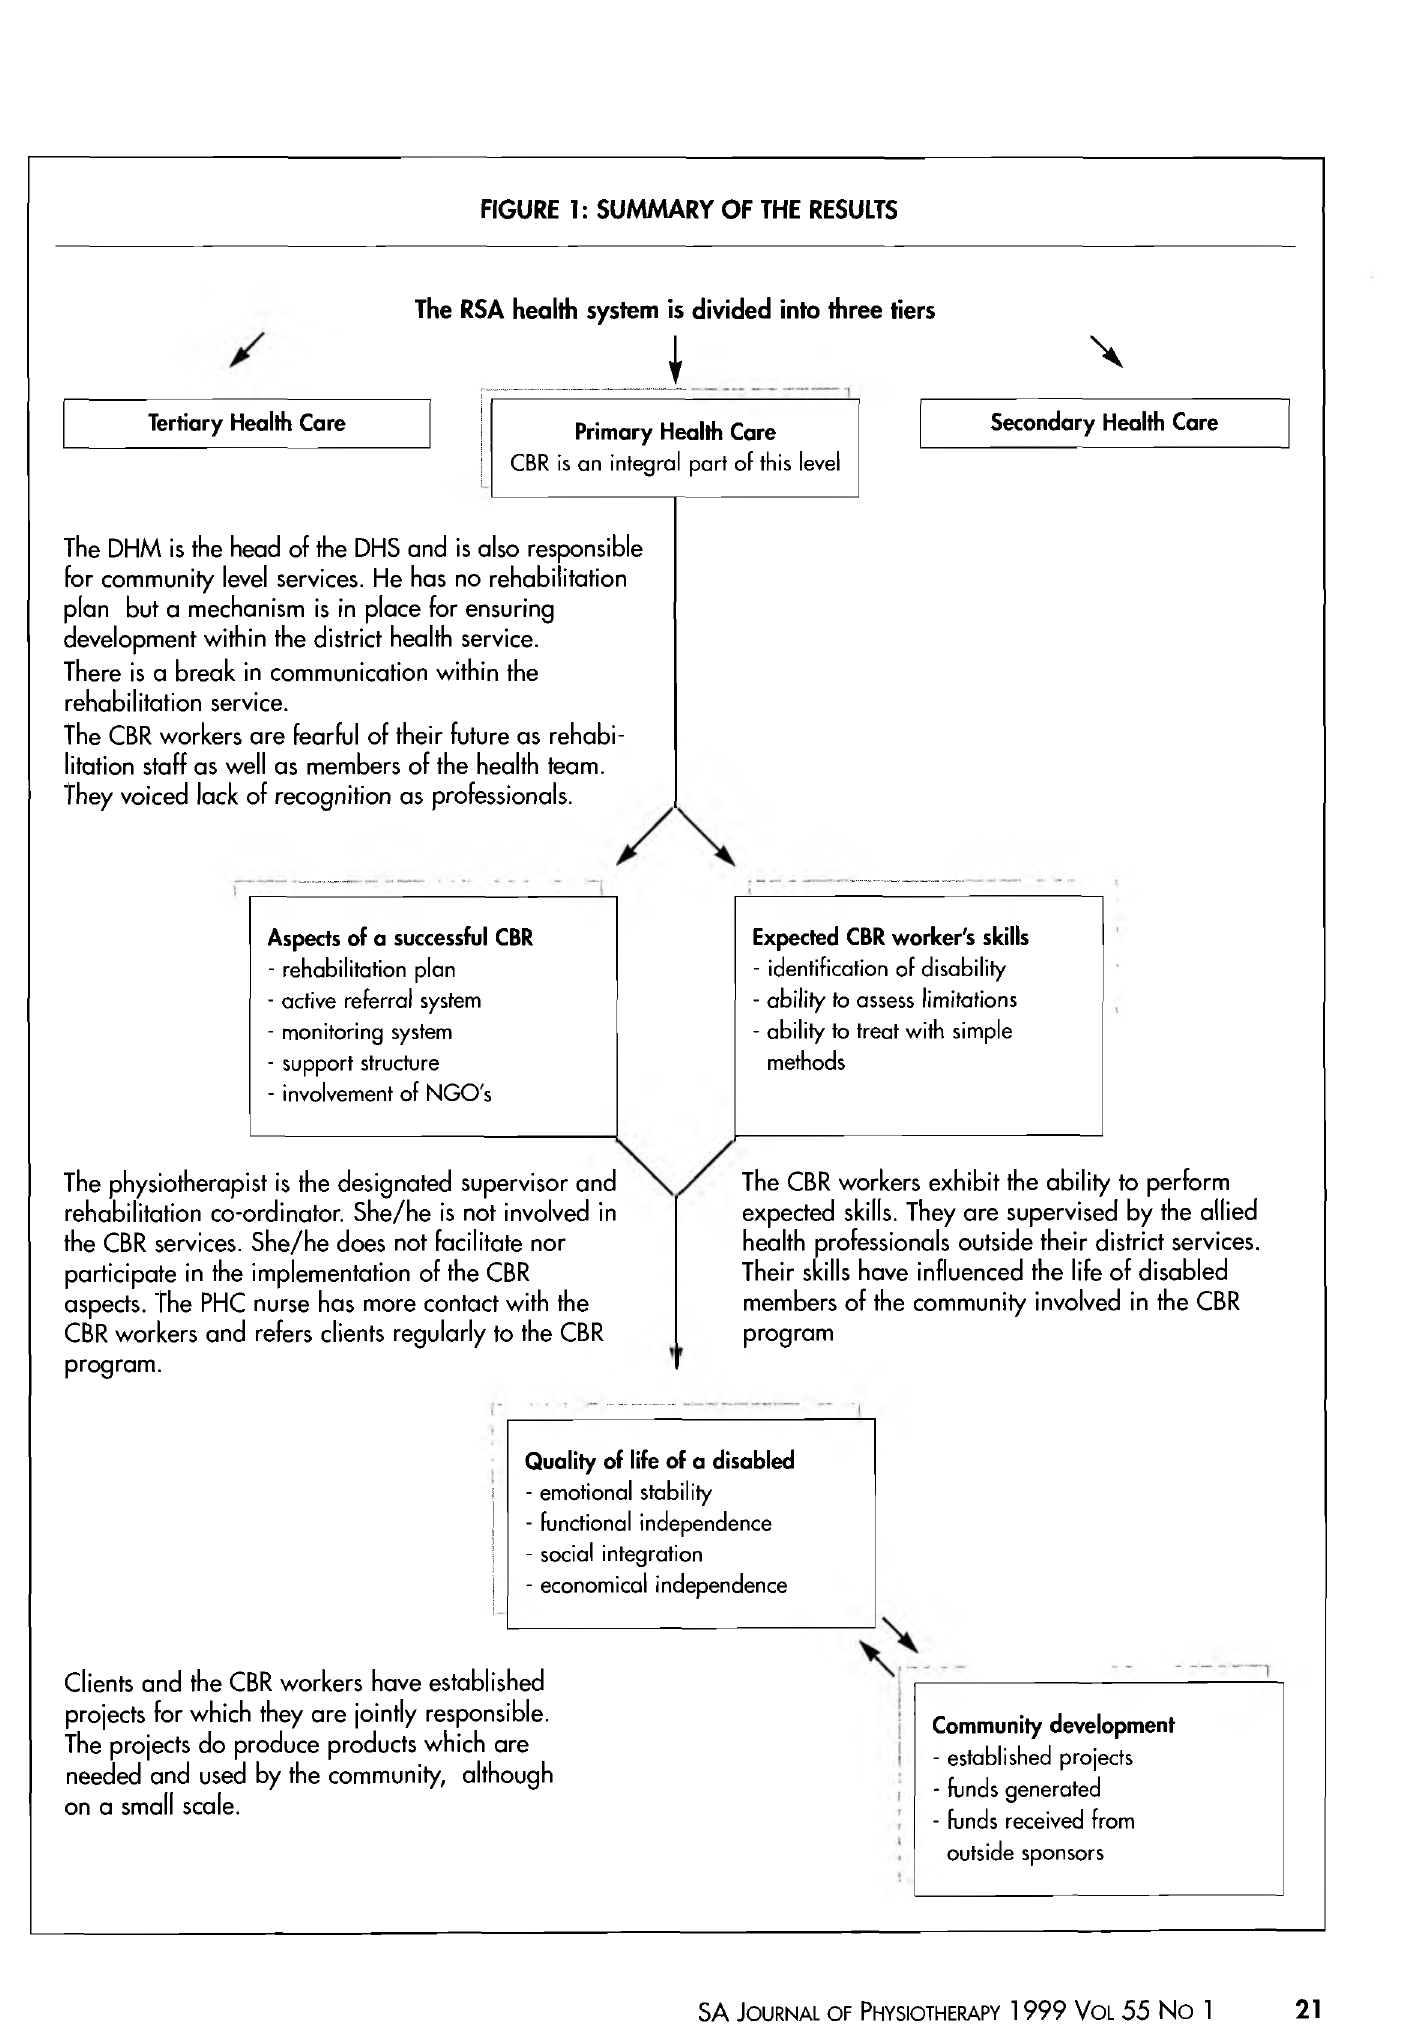
The RSA health system is divided into three